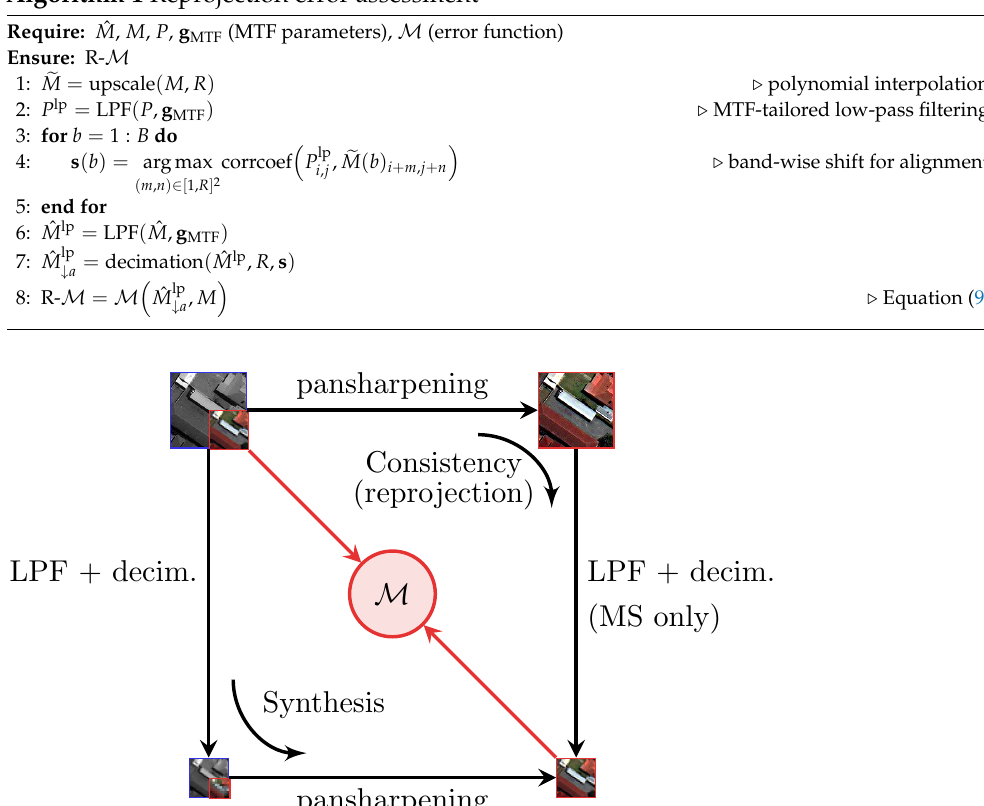
Algorithm 1 Reprojection error assessment